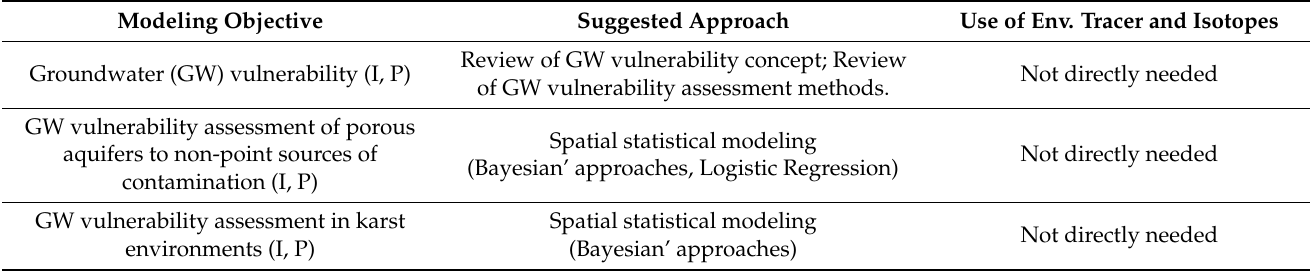
Table 5. Statistical groundwater vulnerability assessment. General purposes: (I) Interpretation: models are applied to help the interpretation of processes as described by field or laboratory data; (D) Design: models are applied to evaluate and compare the performance of design alternatives; (P) Prediction: models are applied to provide a final, quantifiable prediction of actual field